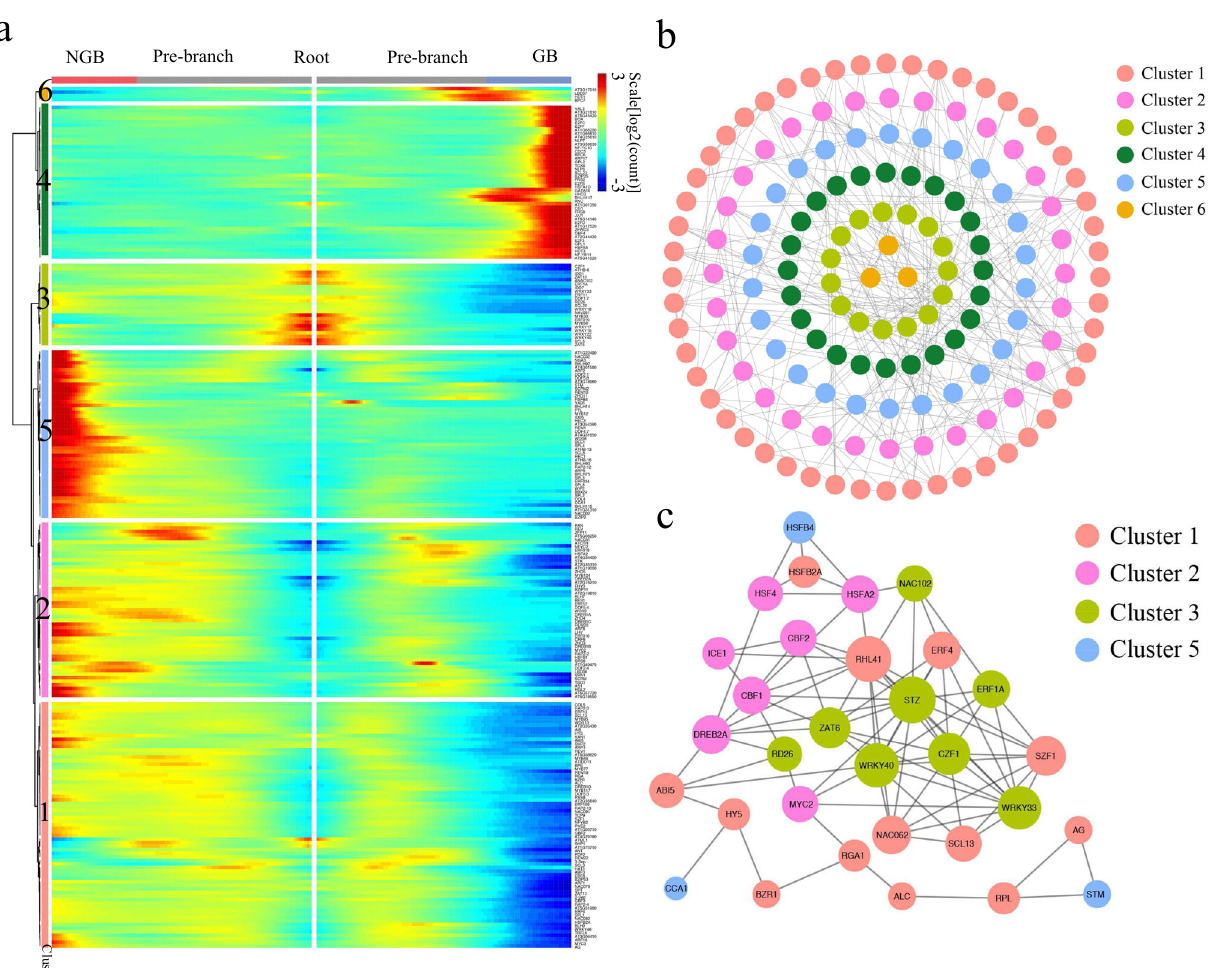
Fig. 5 Transcription factor (TF) expression during MMC differentiation. a Branched heatmap showing 235 TFs with branch-speci fi c expression patterns in pseudotime. The root of the tree is in the middle of the plot, and expression from the earliest cell to the non-germline cells of the NGB is shown progressing to the left, whereas the germline cell progression in the GB is shown progressing to the right of the root. b Correlation network of 153 TFs that are differentially expressed between branches with a degree cutoff of 1. TFs are colored according to their assignment in the gene clusters in ( a ). c The same correlation network with a degree cutoff of 6. Node size is equivalent to the number of predicted